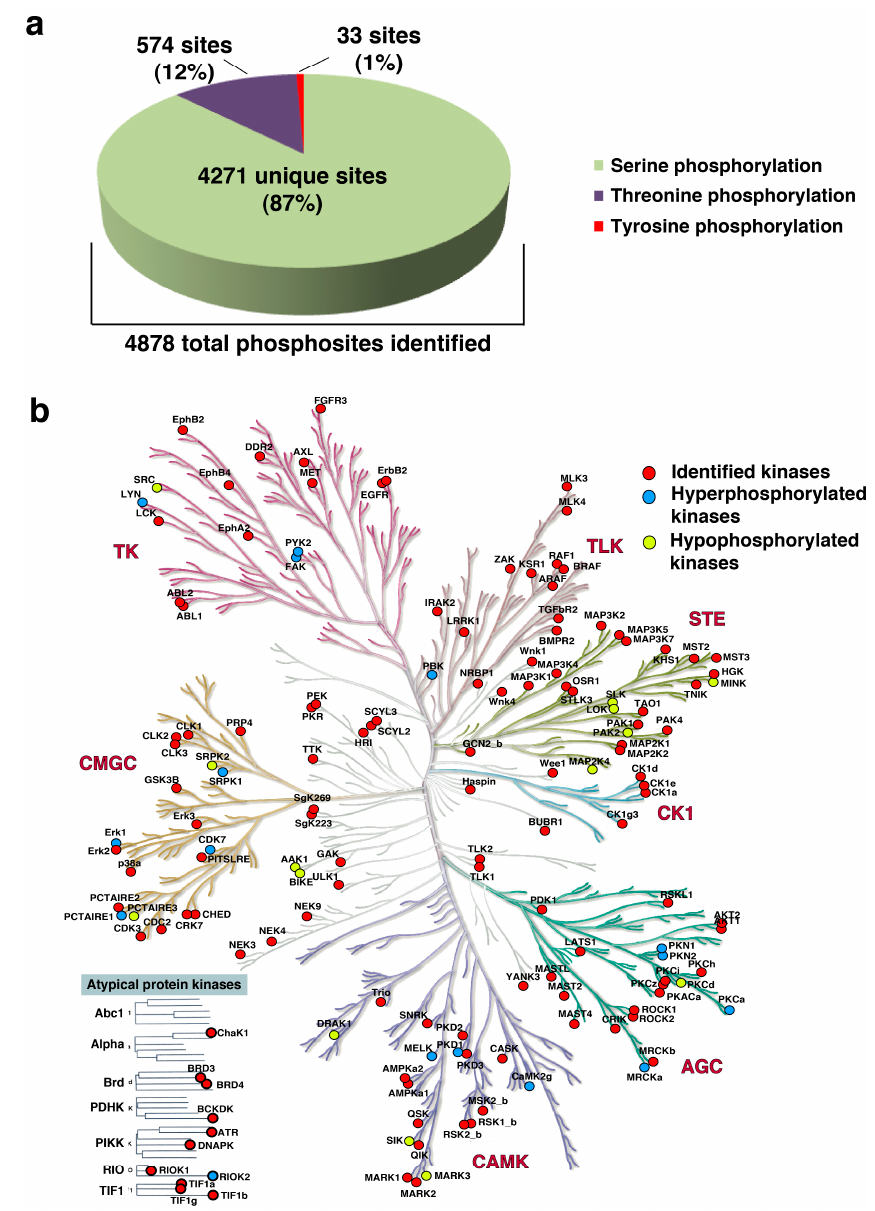
Figure 3. ( a ) Pie chart depicting the phosphosites identified in the study. Identification of the unique phosphosites (percentage of unique serine, threonine, and tyrosine sites identified in the study is mentioned). ( b ) Kinome map depicting the identified kinases in the dataset. Kinases are highlighted as in the inset legend. The map was built using the KinMap tool.